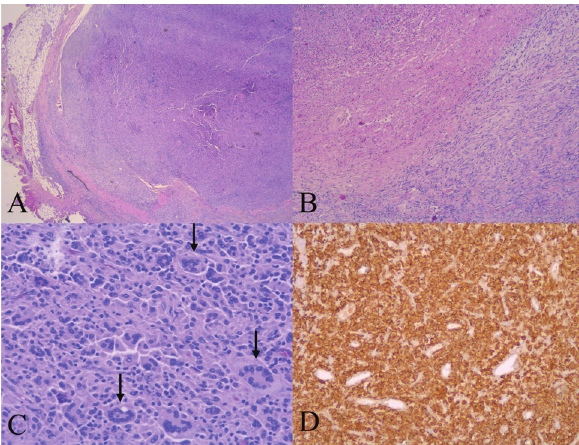
Fig. 4 Histological images of ( A ) encapsulated, nonin fi ltrative tumor, surrounded by normal adipose tissue, ( B ) histiocytic cells (lower part of the image) and necrosis areas (middle area), ( C ). histiocytes intermixed with multinucleated Touton cells (arrows), ( D ) immuno- histochemistry for